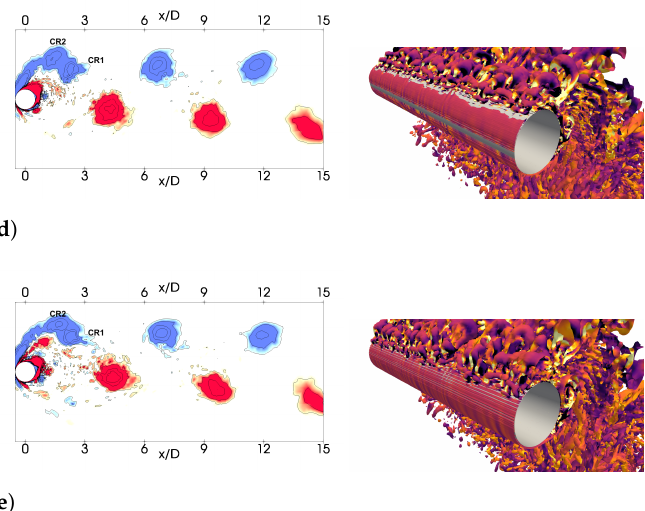
Figure 18. Coherent structures evolution along the half-vortex-shedding cycle of the cylinder re- constructed with 10 modes. ( a ) Lift coefficient evolution; ( b ) span-wise vorticity contours (left) and stream-wise vorticity contours at point A of the lift curve; ( c – e ) the same as at points B, C, and D, respectively. CCR and CR stand for counter-clockwise- and clock-wise-rotating vortexes,